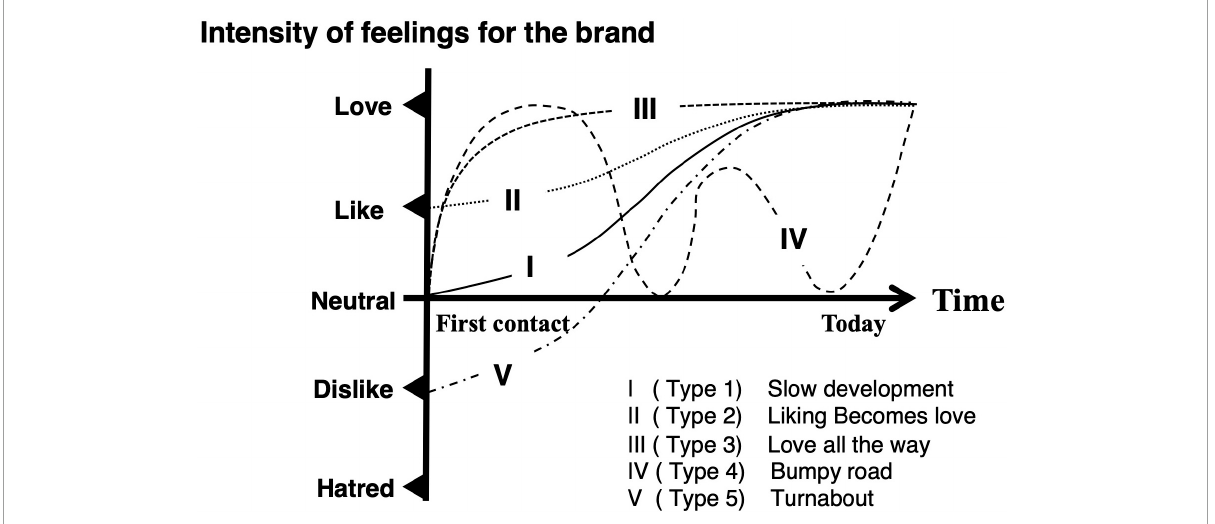
FIGURE1 Brand love trajectories as defined by Langner et al. (2016) were modified and reorganized by the present author. Reprinted with permission from Springer Nature (License 5423700948437).